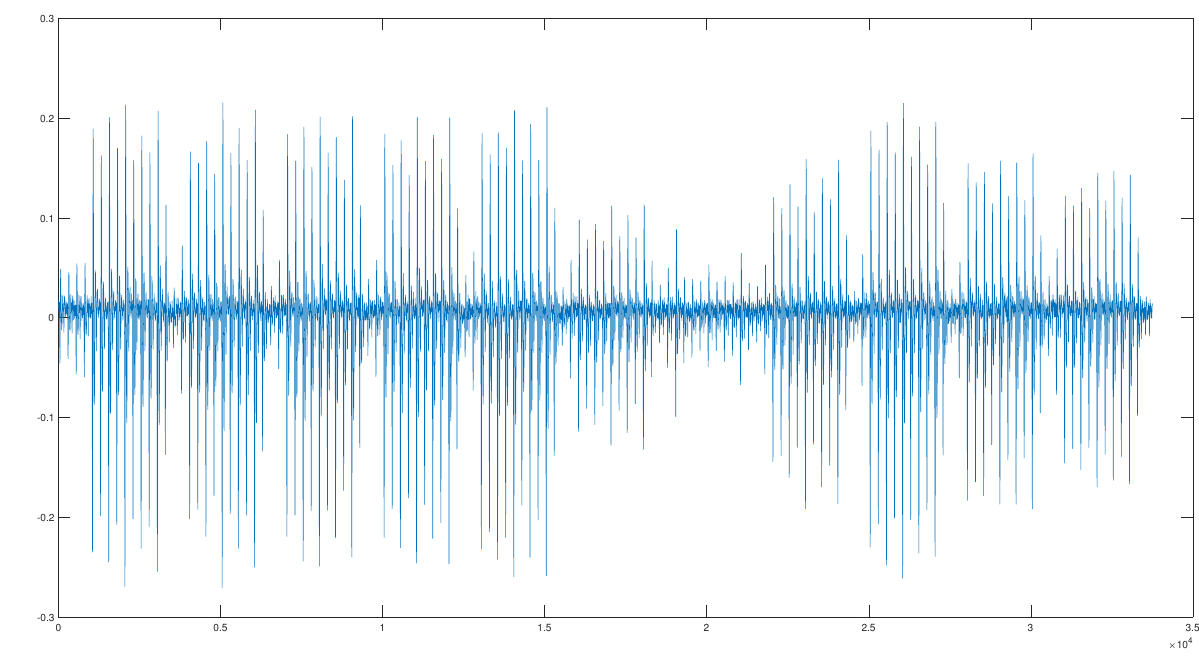
Figure 2. Sample of Unprotected implementation representing bit 0.